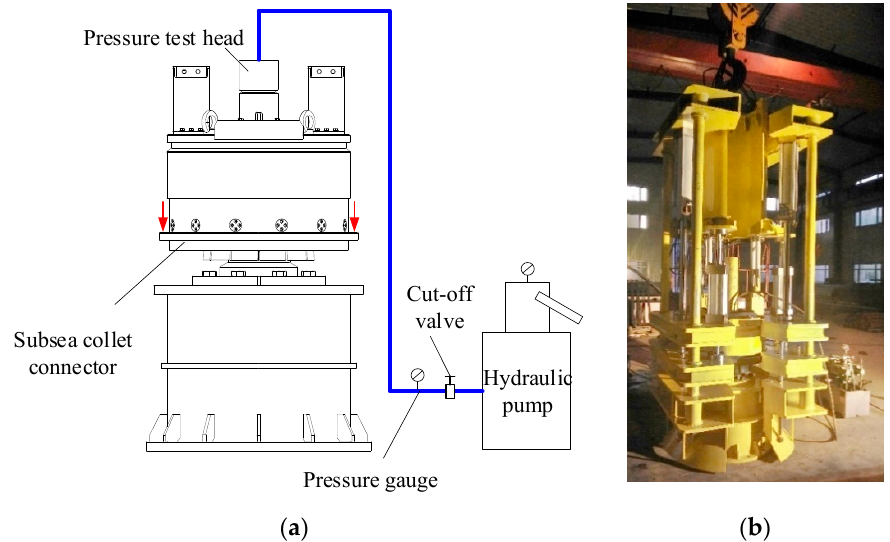
Figure 9. Schematic diagram of the hydrostatic internal pressure experiment. ( a ) Experimental scheme; ( b ) Photograph of the experimental device.